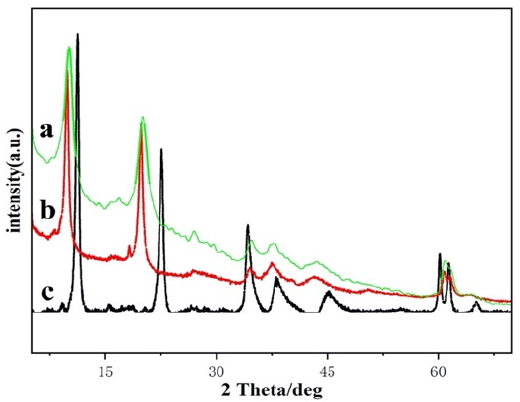
Figure 4. XRD patterns of re-Mg 3 Al–Pro-LDHs ( a ), Mg 3 Al–Pro-LDHs ( b ), and Mg 3 Al–LDHs ( c ).